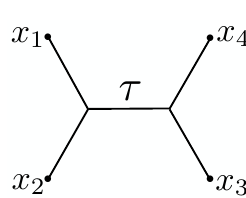
Figure 2. The optimal Steiner tree τ for this configuration of 4 points contains two extra